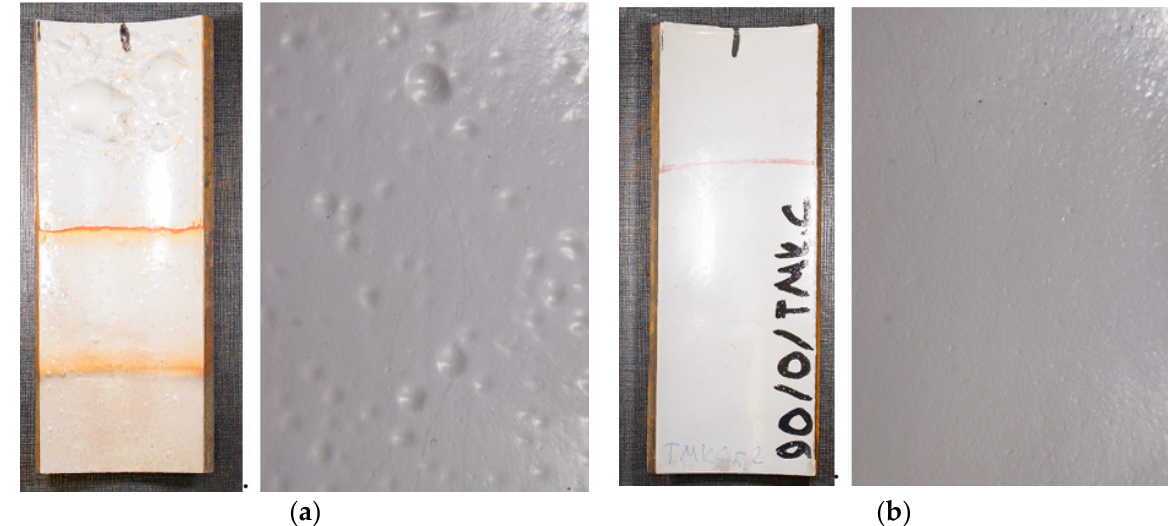
Figure 8. Influence of pressure release time during autoclave tests on decompression within 5 s: ( a ) pressure release within 1.5 s; ( b ) pressure relief in 4.9 s.